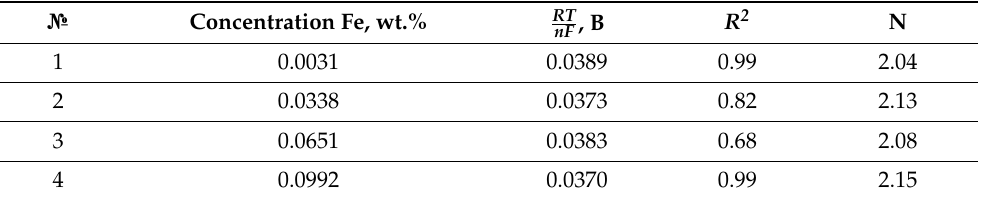
Figure 6. Straight line regions of iron electrode polarization in the 0.66LiF–0.34BeF 2 melt , wt.%: 1—0.0031; 2—0.0338; 3—0.0651; 4—0.0992. Table 4. Coefficients of equations for the straight line regions of polarization curves and the number of electrons are calculated according to the angular coefficient at 923 K.